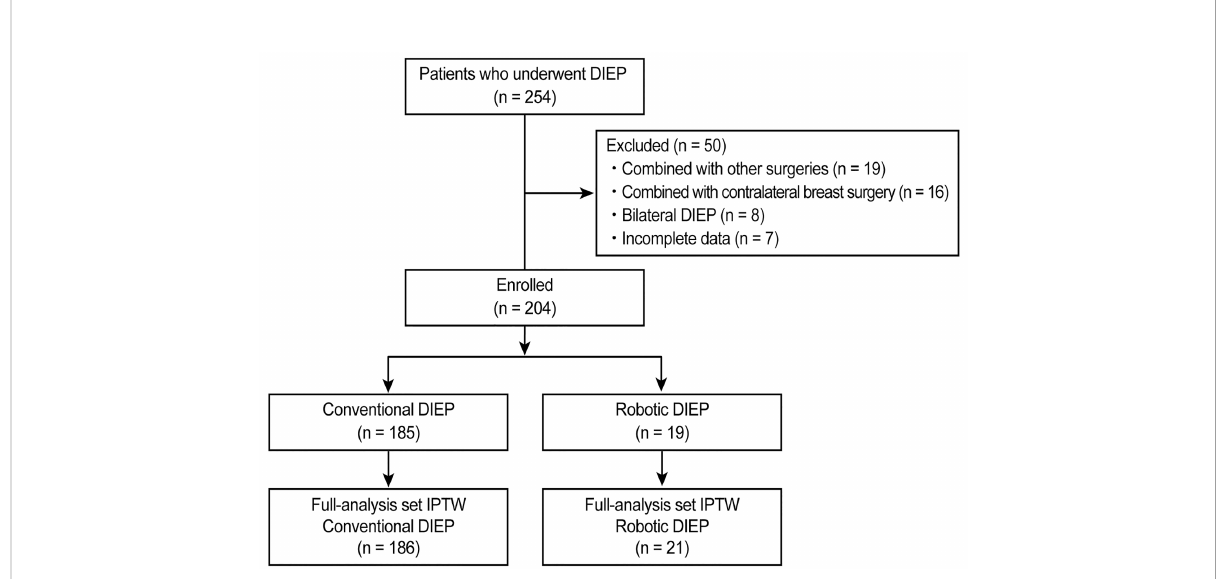
FIGURE 1 CONSORT fl ow diagram of patient selection. DIEP, deep inferior epigastric perforator; IPTW, inverse probability of treatment